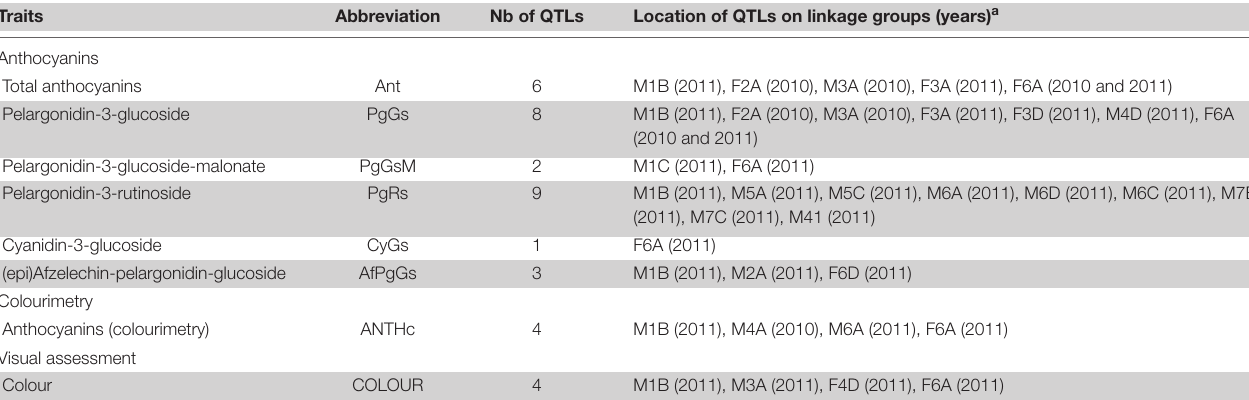
TABLE 2 | Distribution of significant anthocyanin mQTLs and visually assessed COLOUR QTL in the male (M) and female (F) linkage maps.